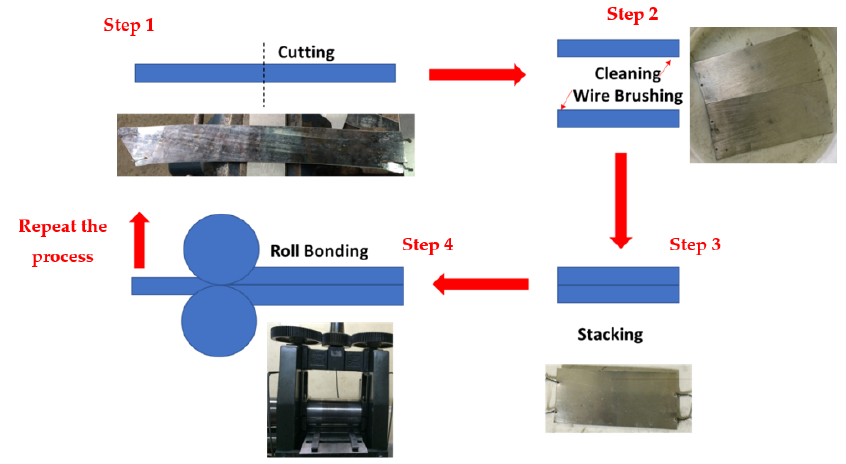
Figure 1. The schematic of the steps involved in the ARB